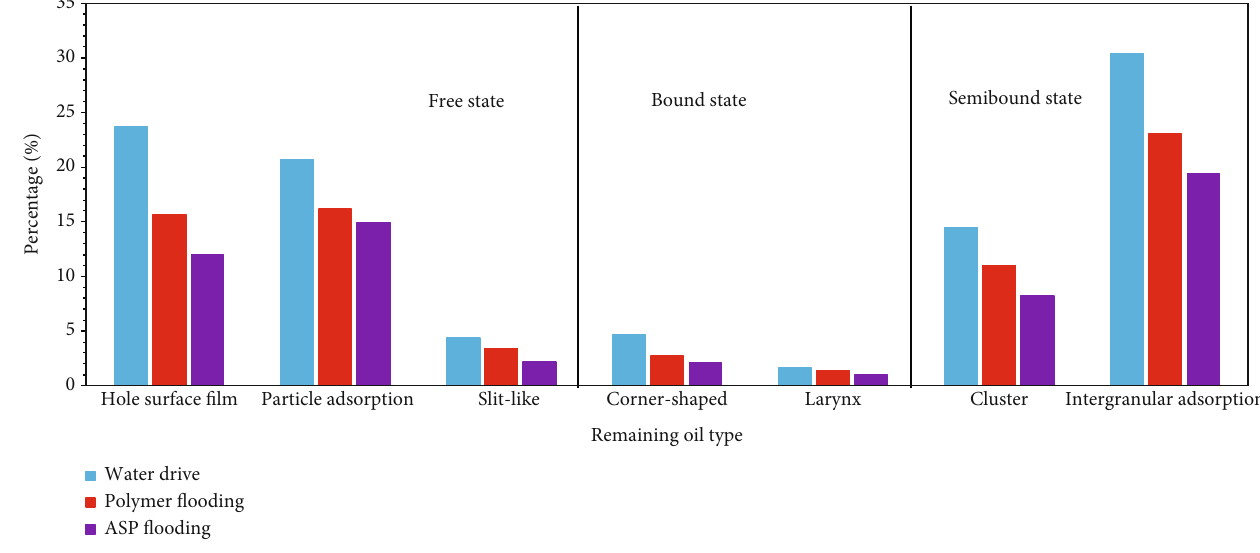
Figure 13: Microscopic residual oil producing degree after di ff erent displacement